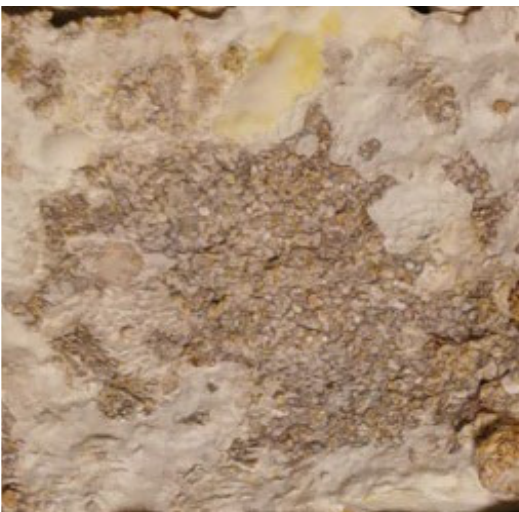
Figure 2. Sample based on hemp mix with buckwheat. Surface: rough, visible substrate fibers; color: two shades of gray (photo A. Bonenberg).